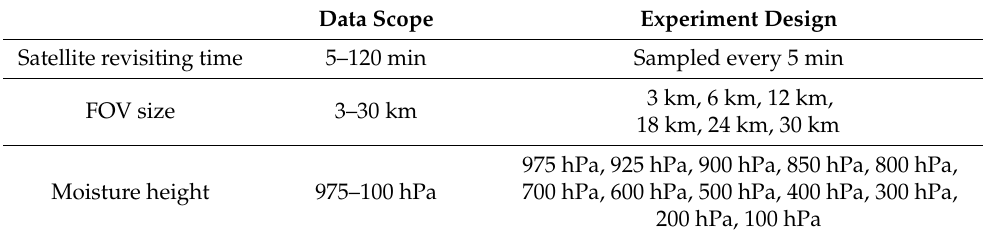
Figure 1. Simulated water vapor field with different spatial resolution of 3 km ( a ) and 30 km ( b ) at 12:00 on 8 August 2019 (UTC) 850 hPa. Table 1. Wind track experiment